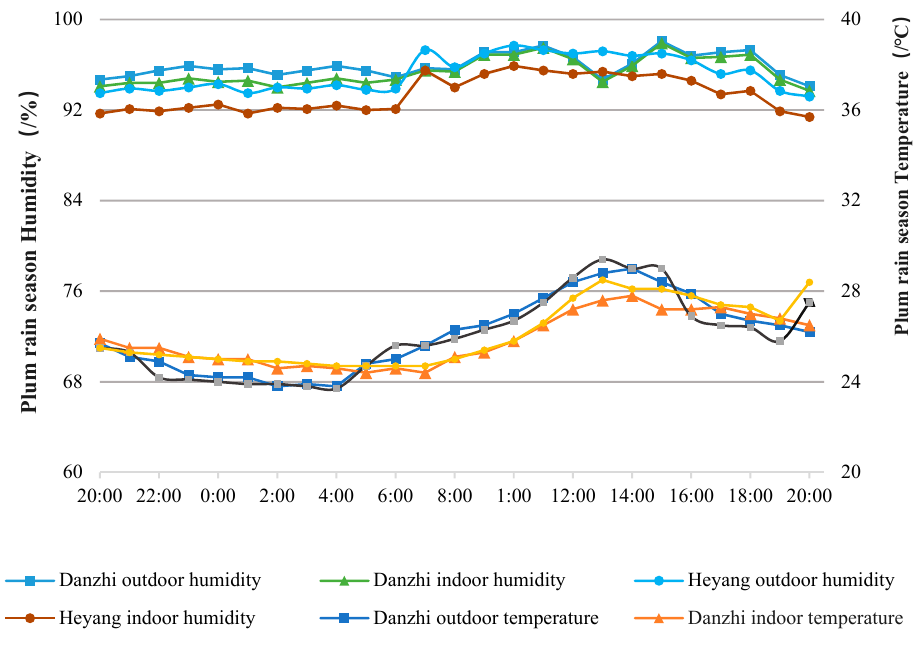
Figure 12. Average temperature and RH in Heyang and Danzhi villages over 24 h during the plum rain season.